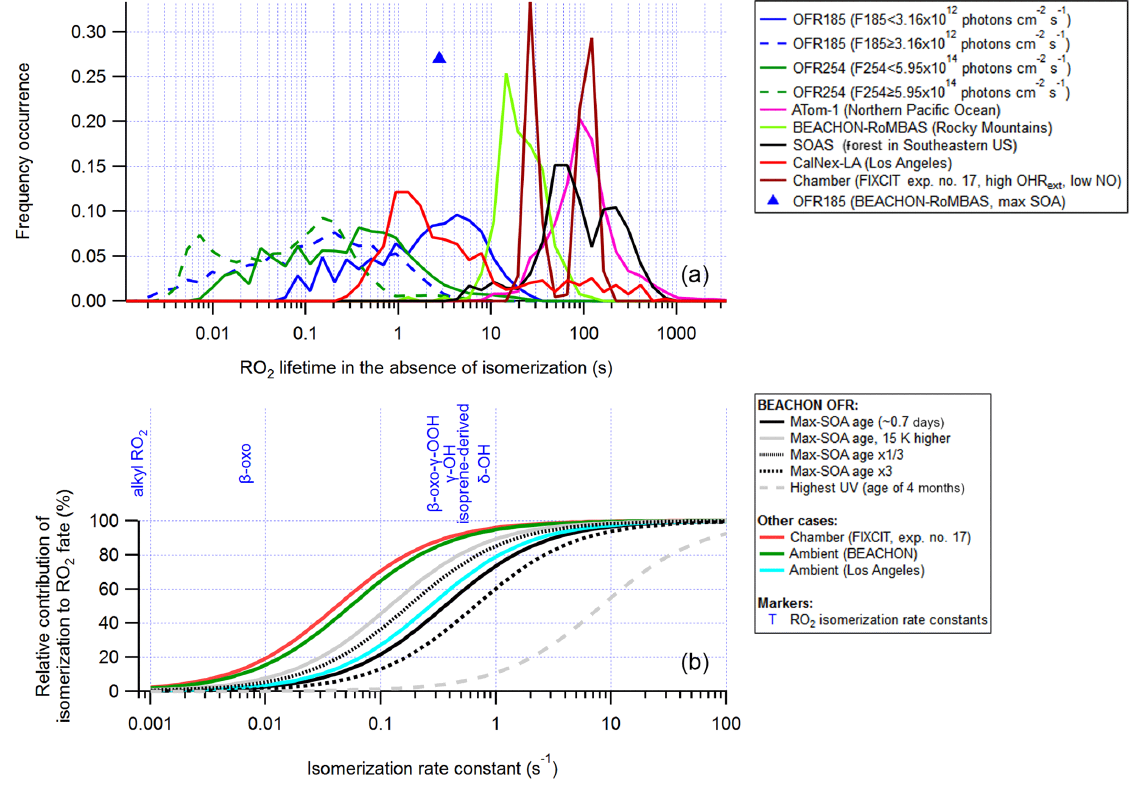
Figure 6. (a) Same format as Fig. 5, but for RO 2 lifetime (RO 2 isomerization included in the model but excluded from lifetime calculation). (b) Relative contribution of isomerization to RO 2 fate as a function of RO 2 isomerization rate constant in several model cases for OFR experiments in the BEACHON-RoMBAS campaign (Palm et al., 2016), in a chamber experiment and in two ambient cases. Isomerization rate constants of several RO 2 types (Crounse et al., 2013; Praske et al., 2018) are also